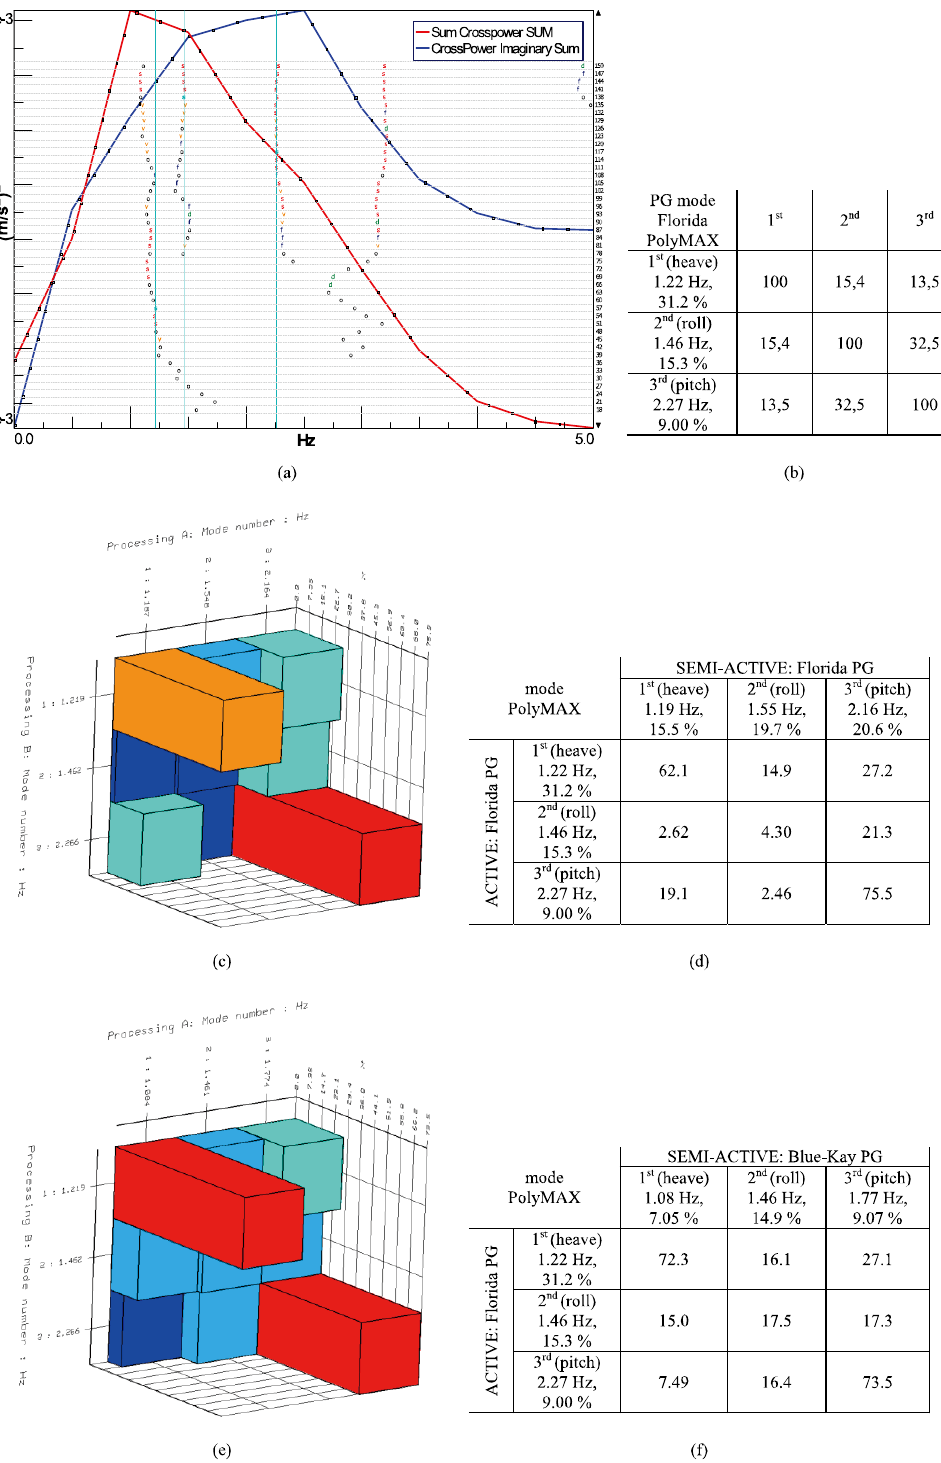
Fig. 9. Active suspension car, proving ground tests: PolyMAX stabilisation diagram and autoMAC table in the Florida case (a, b), MAC matrices and tables in the cases (c, d) active, Florida vs. semi-active, Florida and (e, f) active, Florida vs. semi-active,